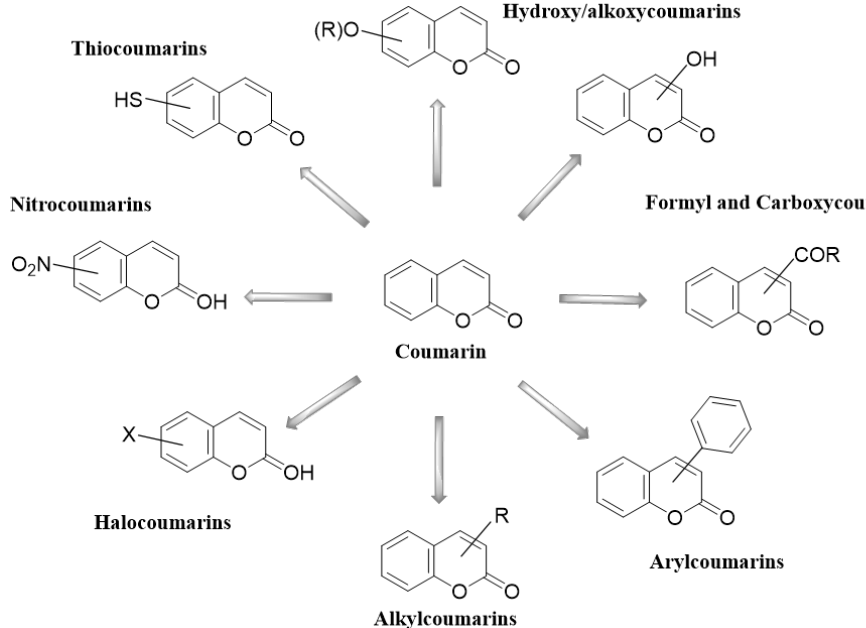
Figure 1. Coumarin as a basic nucleus for obtaining simple coumarins. Taken from Borges, F. et al. (2005) [6]. Accessed date 28 November 2022.